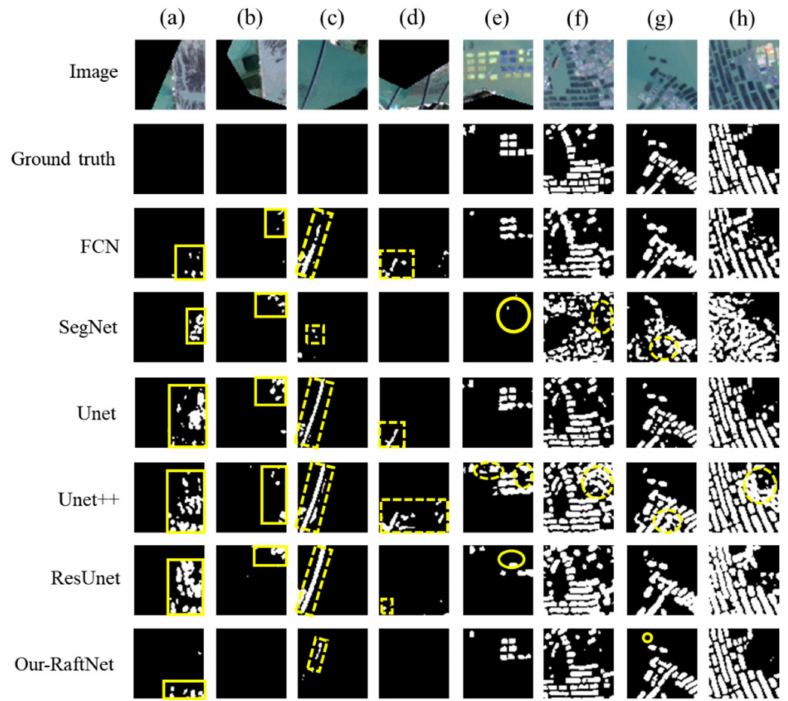
Figure 7. Classification results of raft areas comparing the proposed model with other approaches. ( a – d ) represent scenarios containing coastal vegetation or buildings, ( e – h ) indicate scenarios contain- ing cages. The yellow rectangular solid outlined area indicates coastal vegetation incorrectly classified as raft. The rectangular dotted line indicates artificial constructions misclassified as raft. The oval solid line indicates missing extraction. The oval dotted outlined area indicates cages misclassified as